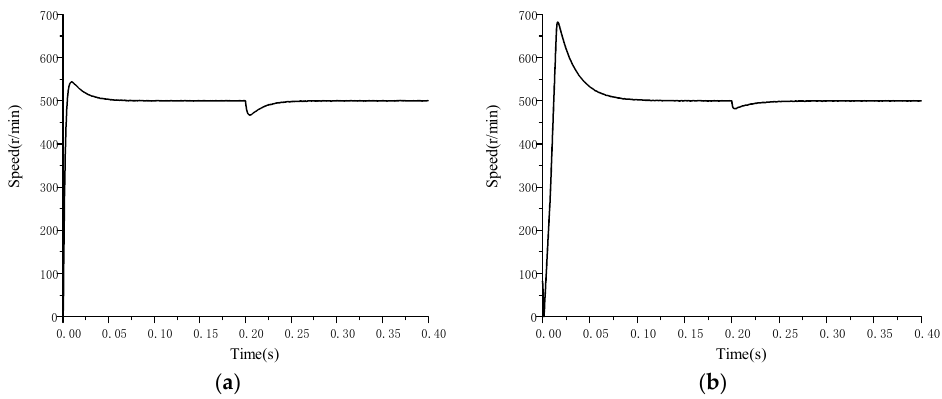
Figure 13. Servo motor speed curve: ( a ) sliding-mode control DTC speed curve; ( b ) traditional DTC speed curve.